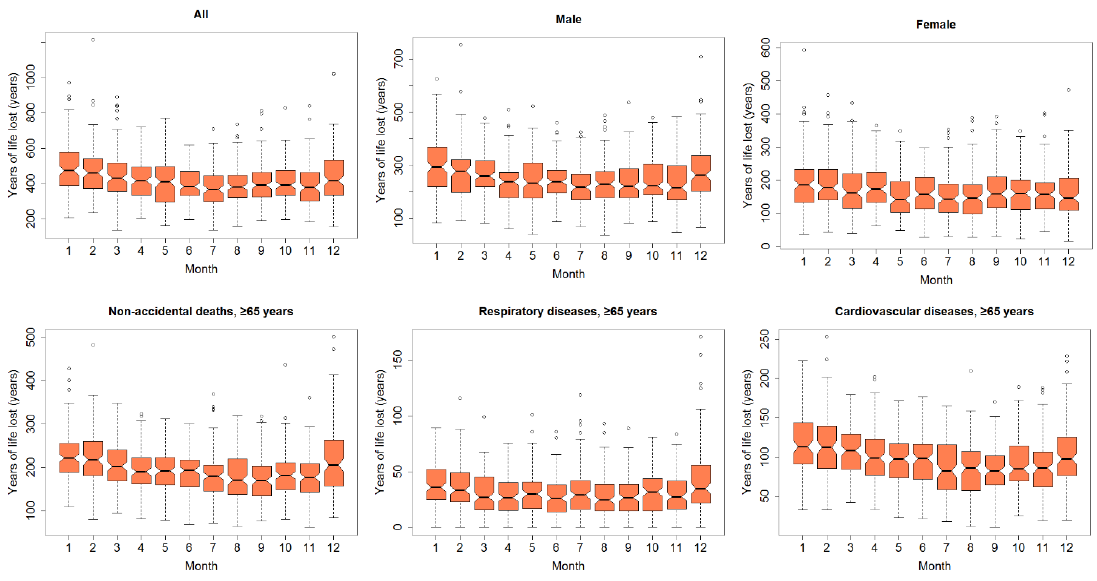
Figure 3. Box plots of monthly years of life lost (YLL) in Lanzhou, China, during 2014–2017.3.2. Single- Day Lag Effects of Cold and Heat.